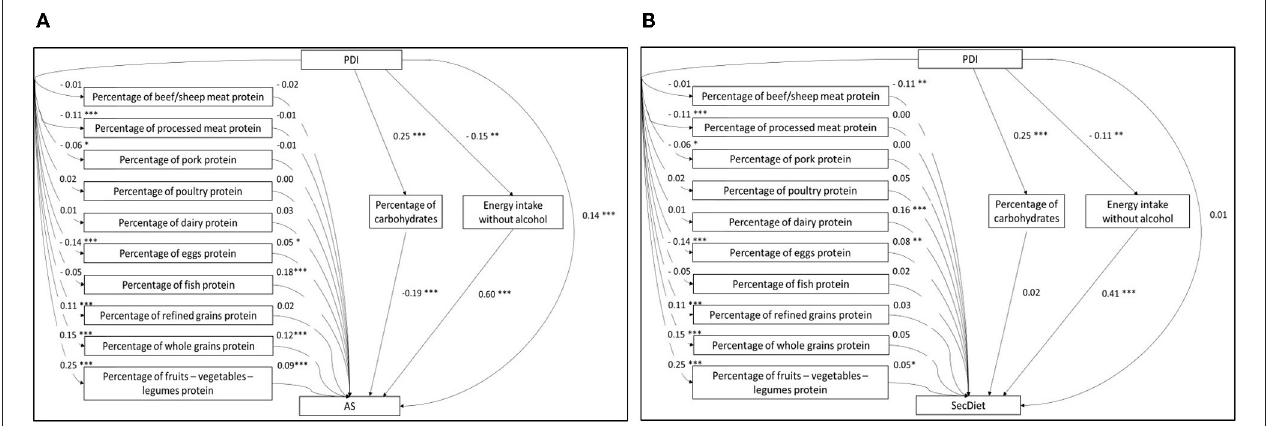
FIGURE 2 | Structural model of the path analyses between the PDI and the AS (A) and the path analyses between the PDI and the SecDiet (B) with the percentage of energy from whole grains protein (%EI), refined grains protein (%EI), dairy protein (%EI), eggs protein (%EI), beef/sheep meat protein (%EI), pork protein (%EI), poultry protein (%EI), processed meat protein (%EI), fish protein (%EI), fruits-vegetables-legumes protein (%EI), carbohydrates (%EI), and energy intake without alcohol as mediators. All regression coefficients are standardized. * P < 0.05, ** P < 0.01, *** P <